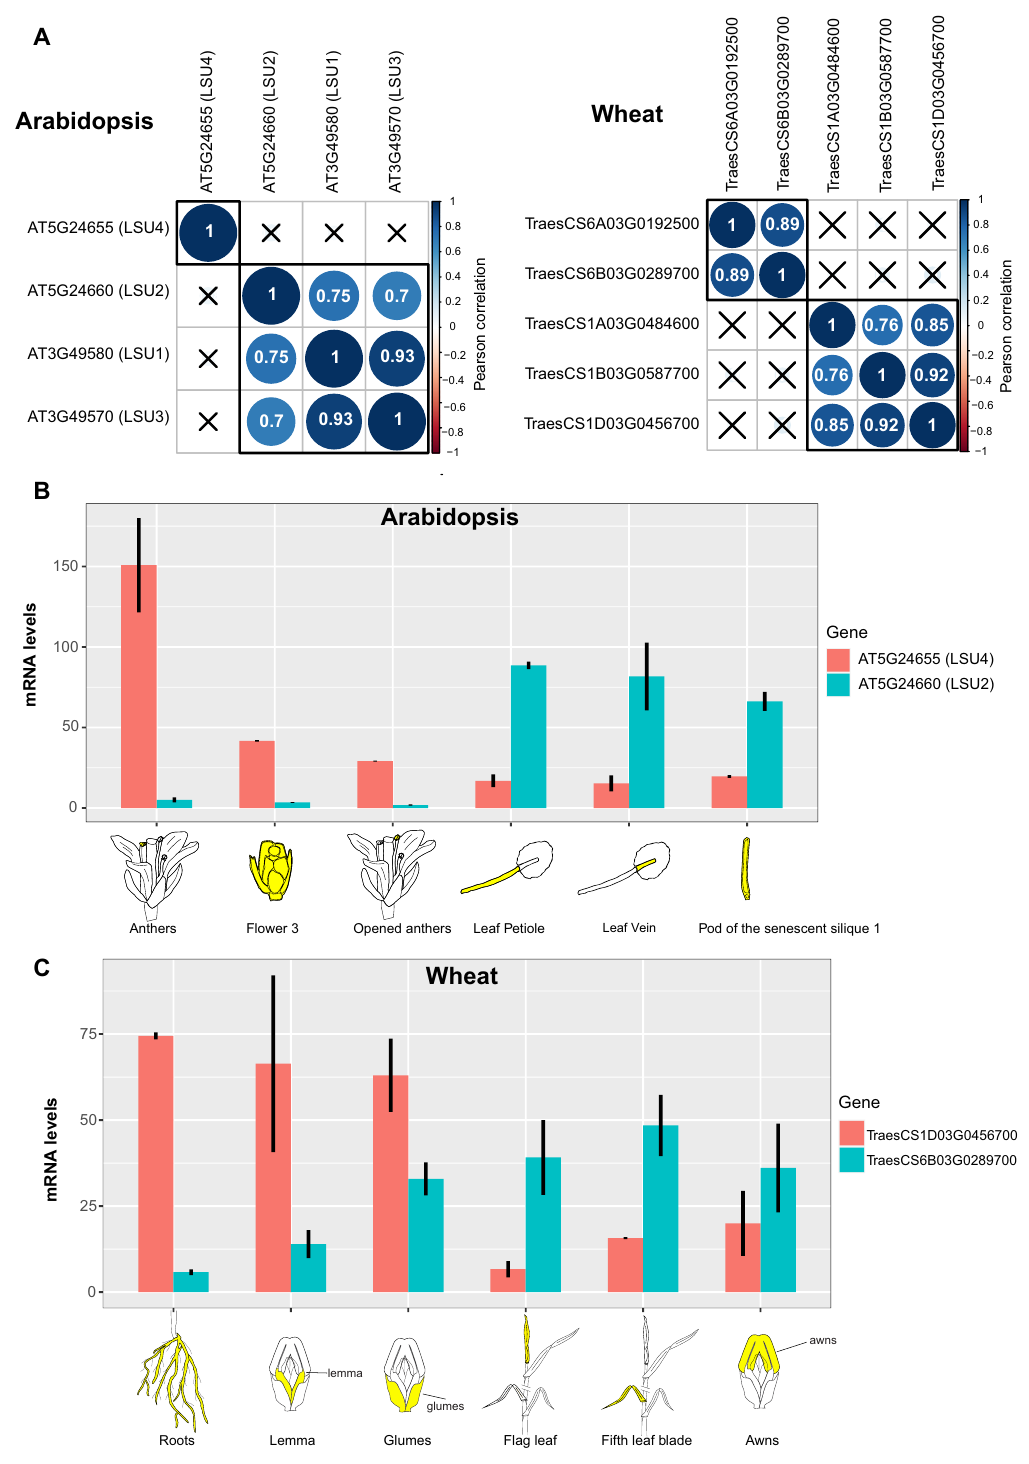
Figure 2. Analysis of the LSU developmental expression atlas in Arabidopsis and wheat suggests the existence of two LSU subgroups with contrasting expression profiles. ( A ) Coexpression analyses of Arabidopsis (left panel) and wheat LSU family (right panel) performed with the r package “ corrplot ” [23] using all samples included in the developmental atlas of ePlant [21]. Only Pearson correlation values with a p -value < 0.01 are shown in the correlation heatmaps. ( B ) Expression profiles of Arabidopsis LSU4 and LSU2 in the three samples with the higher expression of each selected gene. ( C ) Expression profiles of wheat TraesCS1D03G0456700 and TraesCS6B03G0289700 in the three samples with the higher expression of each selected